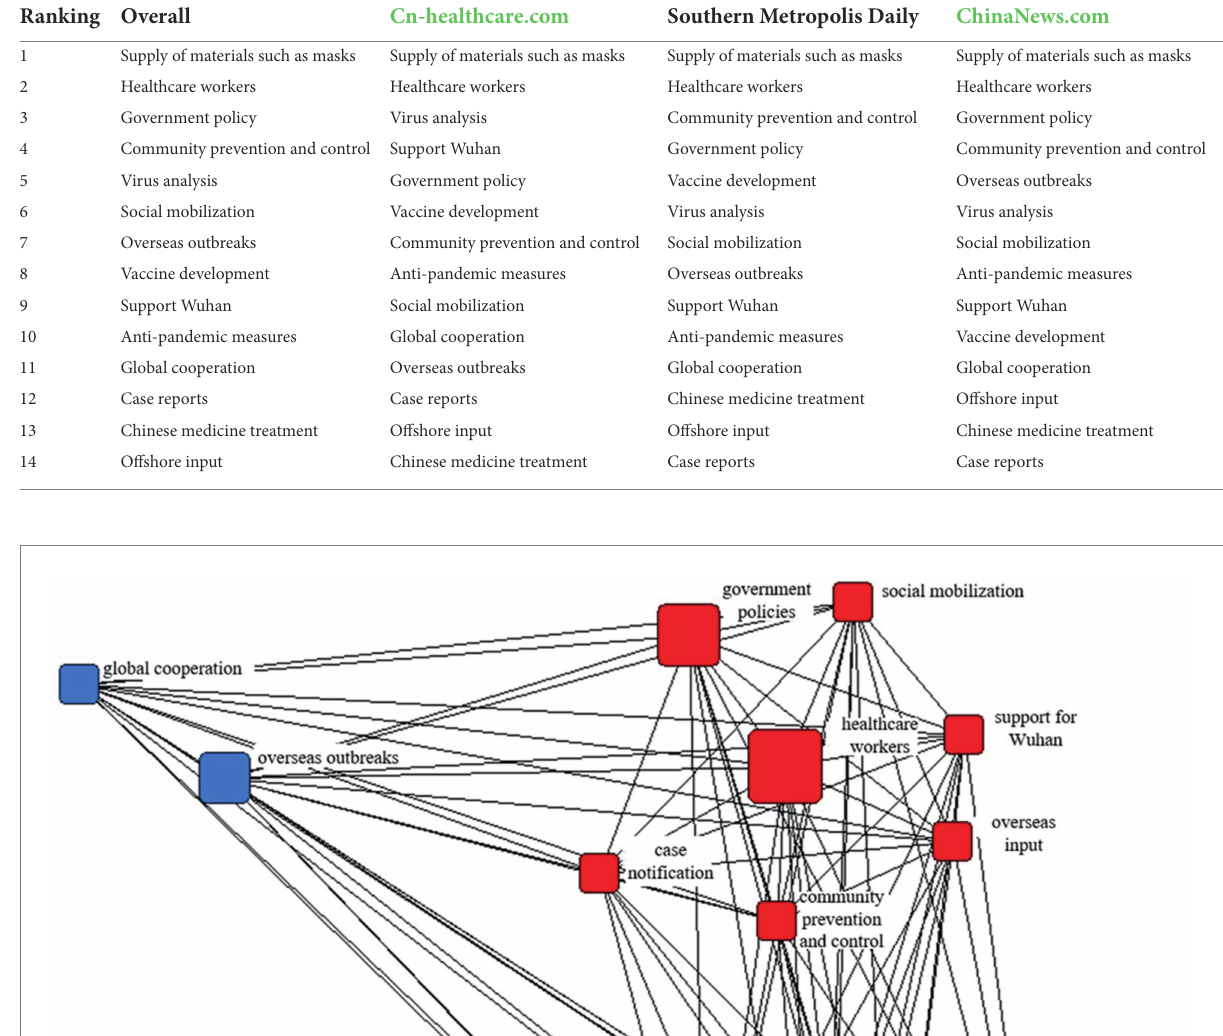
TABLE 6 Topic ranking in different media.